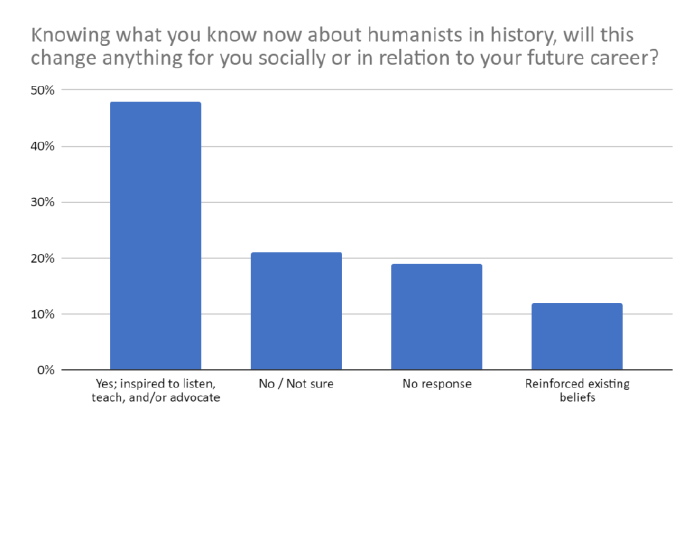
Table 4: Impacts of Study on Participants